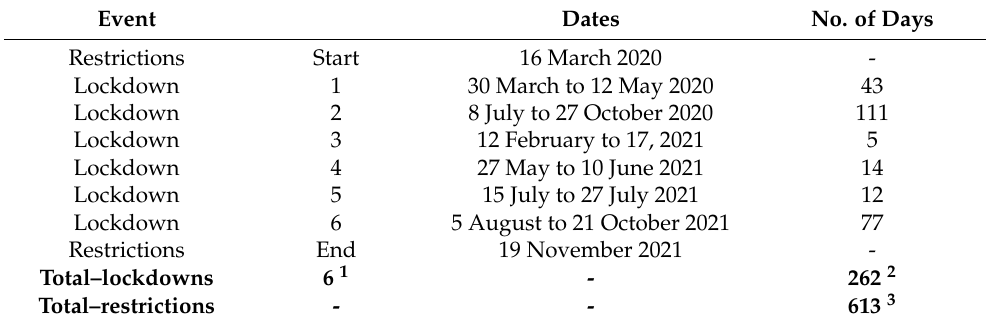
Table 1. Dates and duration of COVID-19 restrictions and lockdowns in Melbourne, Australia.